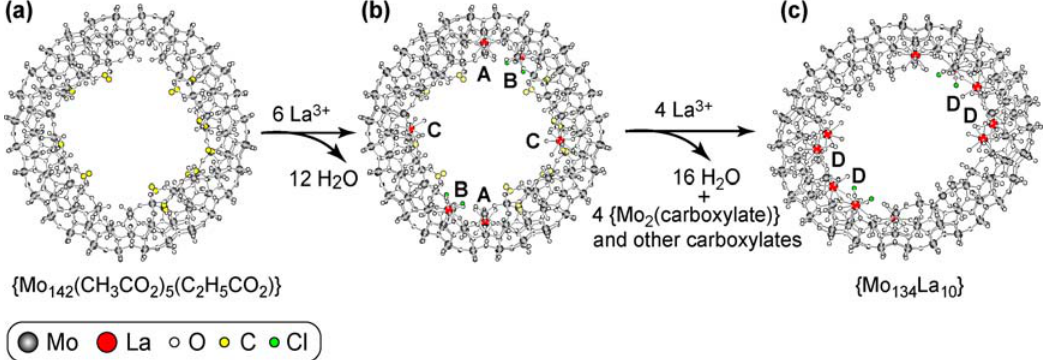
Figure 4. Two steps of the coordination of {Mo aqueous solutions. The removal of the coordinated carboxylates from the Mo-blue ring